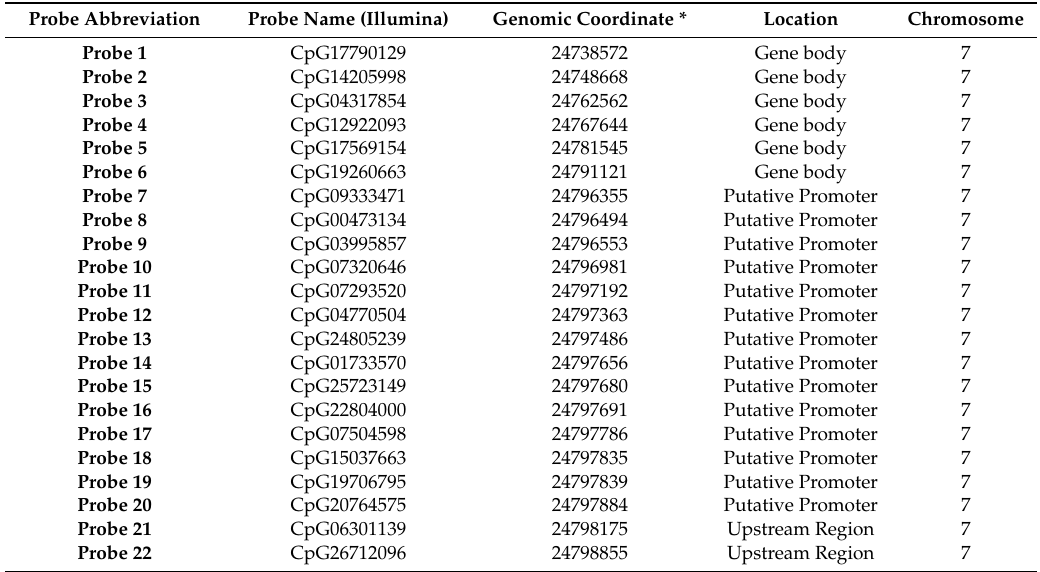
Table 2. Table outlining the GSDME Illumina Infinium HumanMethylation450 probes along with their genomic